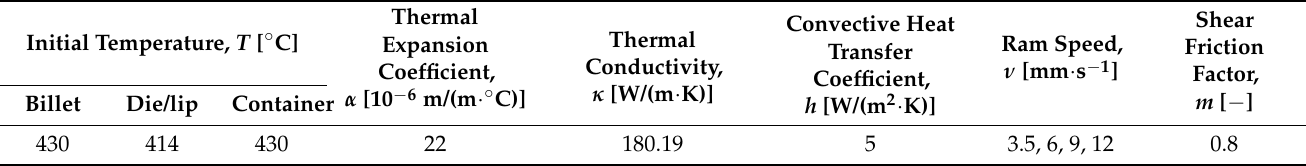
Table 3. Information related to the numerical simulation of the L-shaped sample extrusion process.